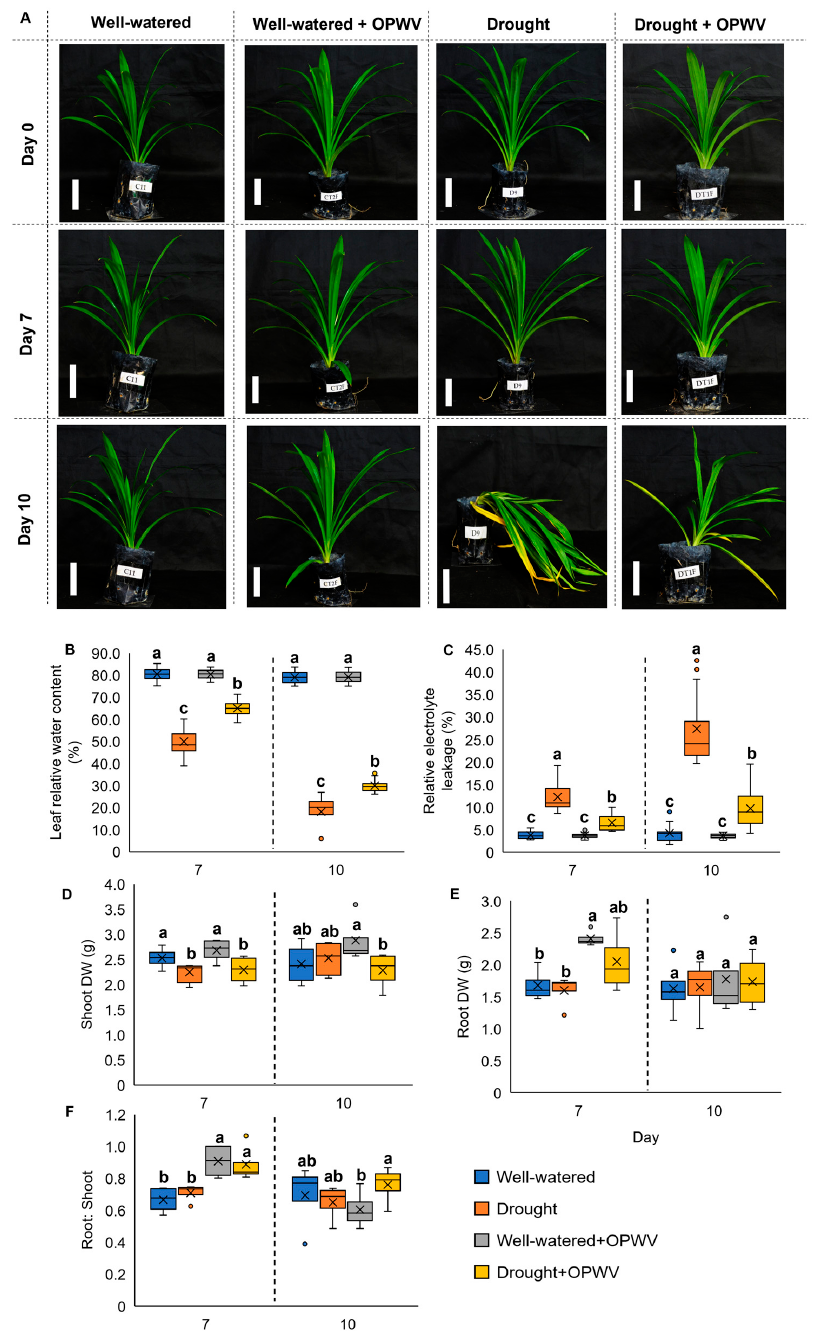
Figure 3. The morphological analysis of the well-watered and drought-stressed Pandanus amaryllifolius plants treated with or without OPWV for 7 and 10 days. ( A ) Representative photographs of P. amaryllifolius under different conditions. Bar = 10 cm. ( B ) Leaf relative water content (LRWC). ( C ) Leaf relative electrolyte leakage (REL). ( D ) The shoot dry weight (DW). ( E ) Root DW. ( F ) Root-to-shoot mass ratio. The letter labelled on the mean value indicates a significant level between treatments based on the one-way ANOVA, followed by the post hoc Tukey test when its p -value < 0.05. The letter ‘a’ above the bars indicates the highest value, followed by ‘ab’, ‘b’, and ‘c’. The ( × ) labelled in the box plot indicates the mean value of the treatment, while the ( • ) refers to the outlier value of the replicates. The plant leaf relative water content (LRWC) and relative electrolyte leakage (REL) were analyzed to investigate the degree of water loss and cell damage within the